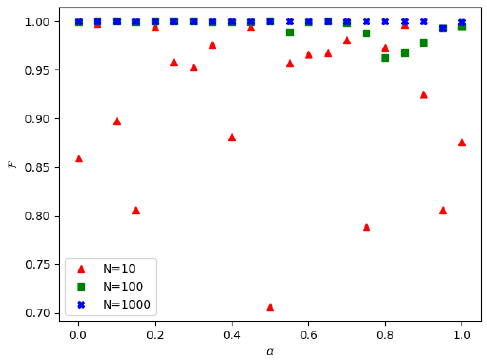
Figure 7. Fidelity of two-qubit Werner states.